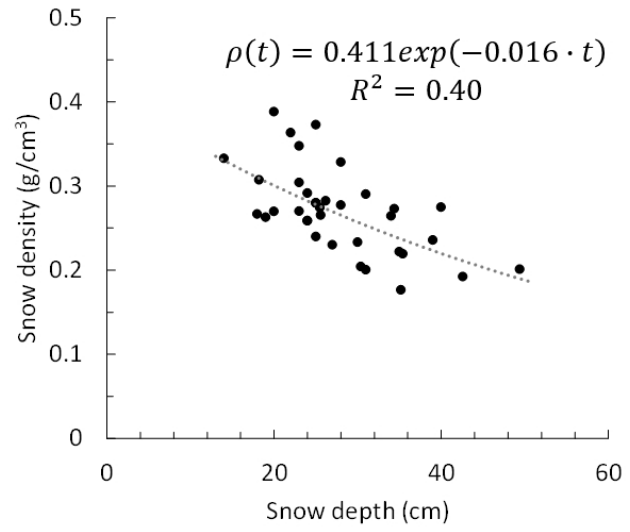
Figure 10. Relation between measured snow depth and density.